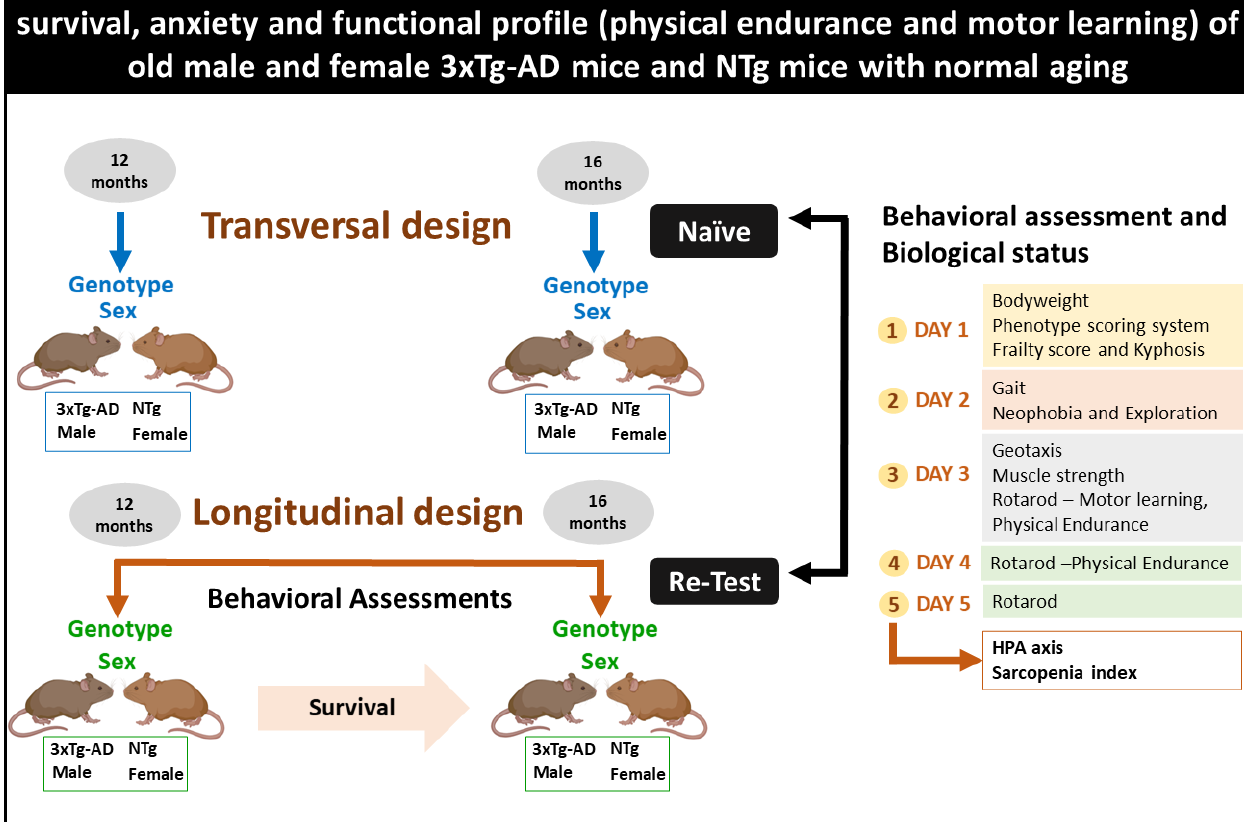
Figure 1. Experimental design. Longitudinal design: the first group was assessed in the behavioral battery at the age of 12 months and again when the animals reached 16 months of age. Transversal design: the second group was housed in standard conditions without manipulation until they were tested at 16 months of age, so they could be compared to re-tested 16 months old